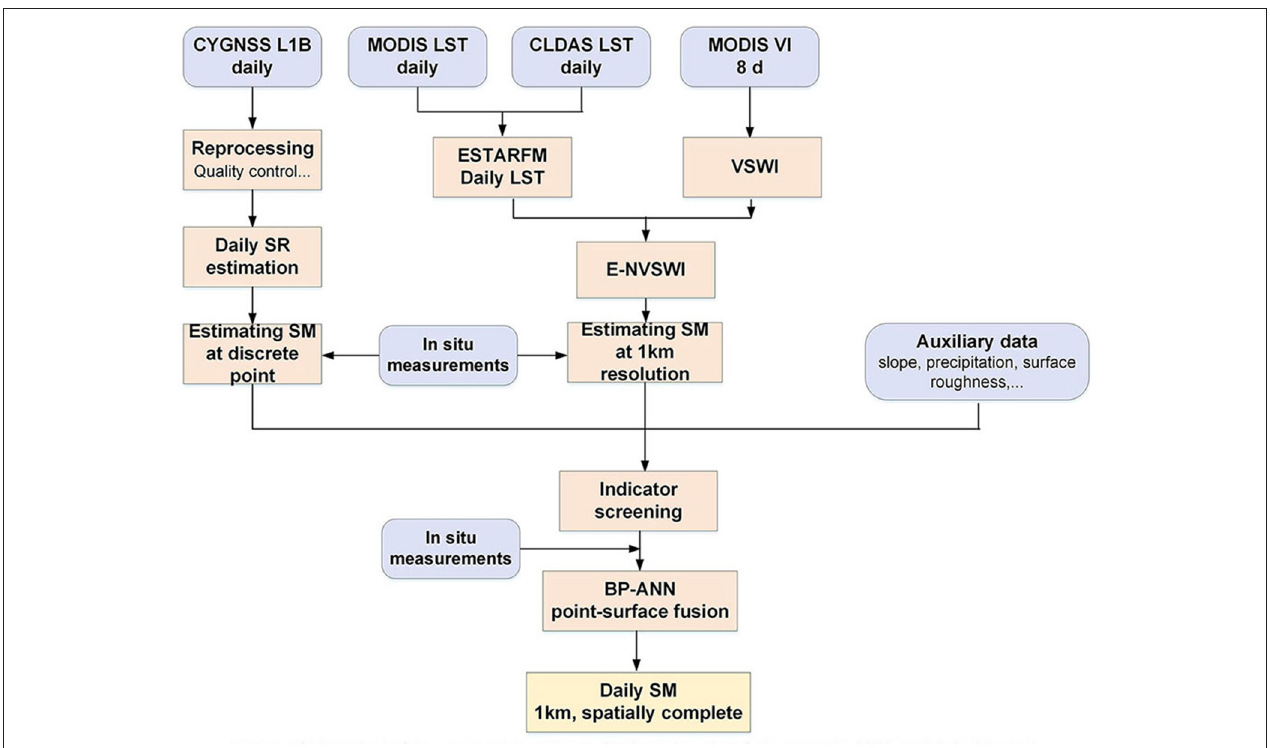
FIGURE 2 | Flow chart of the approach to estimate SM based on data fusion and BP-ANN models in this study.